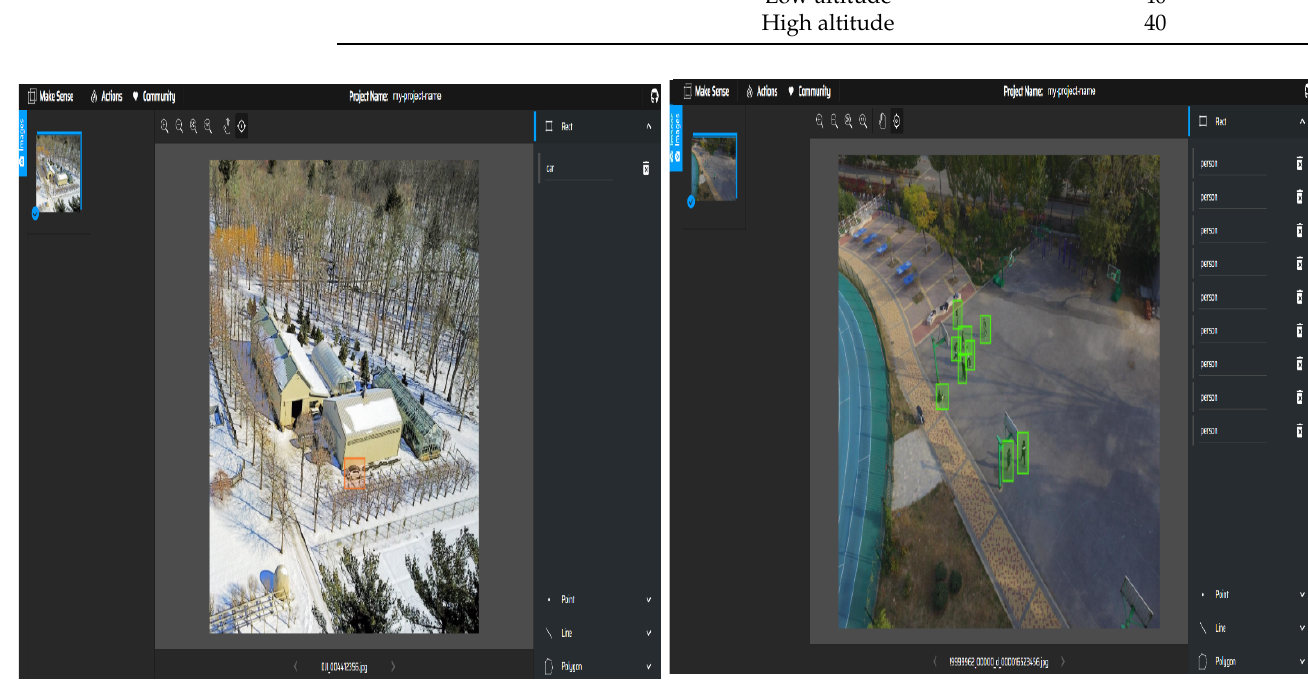
Figure 9. The process of changing data samples collected by drone to YOLO format ( Left figure is the snowy day, Right figure is the evening). Table 1. Dataset classification by various experimental conditions.